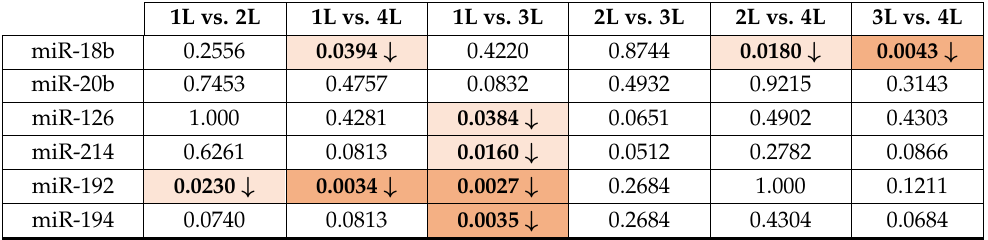
Table 3. Significance of expression differences between groups in the large intestine shown as p values. Up-regulation is marked with an arrow up, down-regulation is marked with an arrow down. 1L vs. 2L 1L vs.